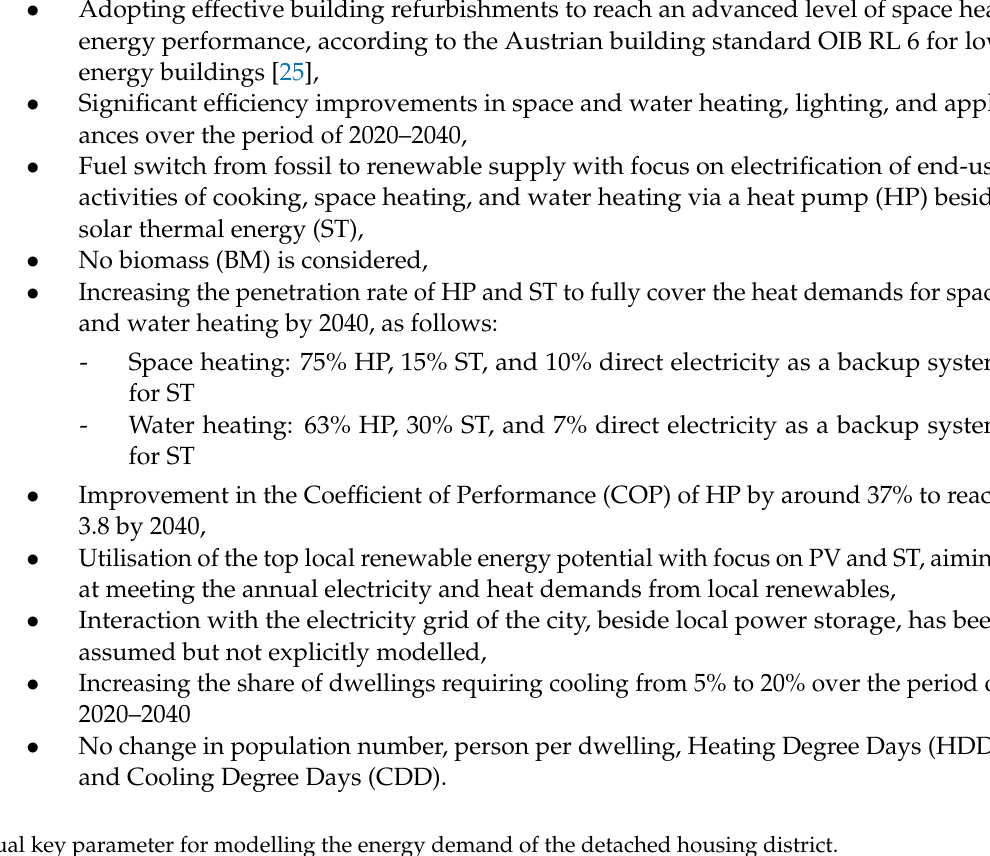
Table 2. Annual key parameter for modelling the energy demand of the detached housing district. Data